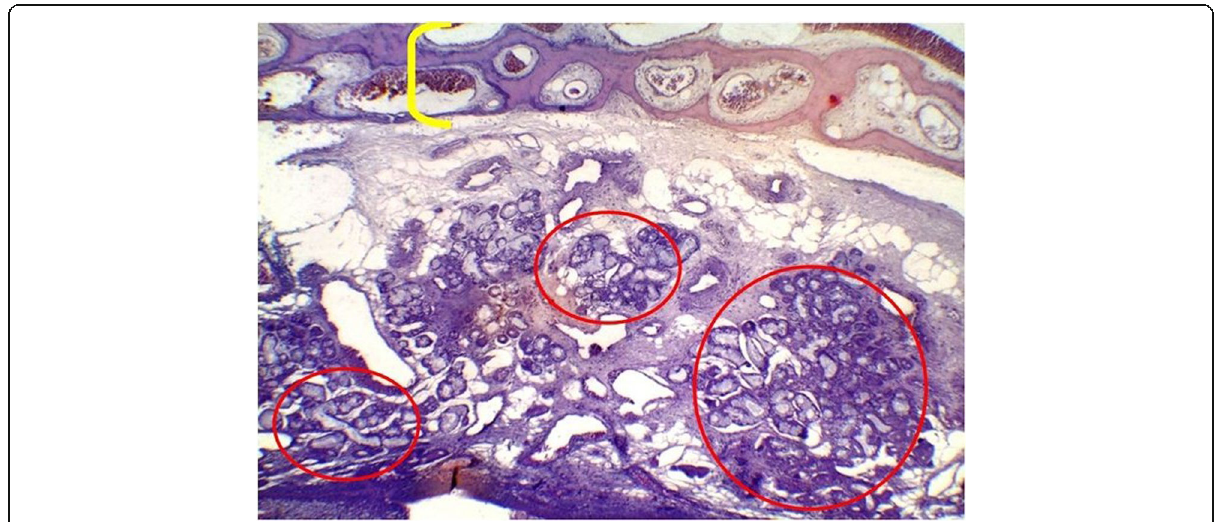
Fig. 3 Nasal turbinate showing respiratory epithelial covering, the subepithelium is thickened by mucous secreting glands (red circles) and thickened bony trabeculae (yellow)